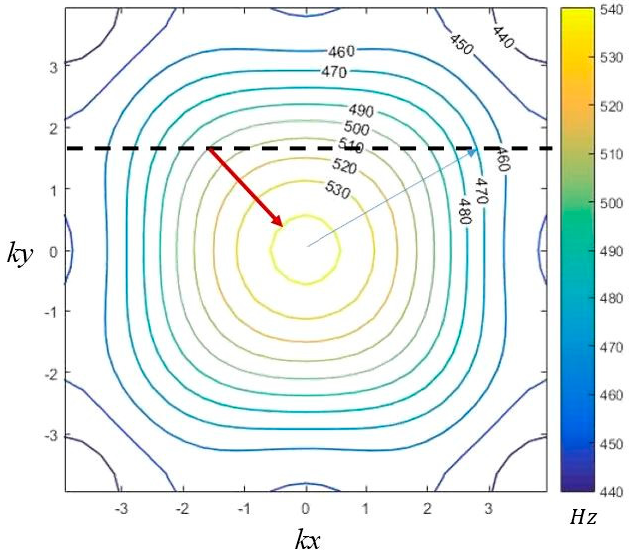
Figure 5. The equi-frequency contour of the third band in Figure 4 (a). The star angle and the effective Poisson’s ratio are 𝜃 = 55° and ν = − 0 . 53, respectively.